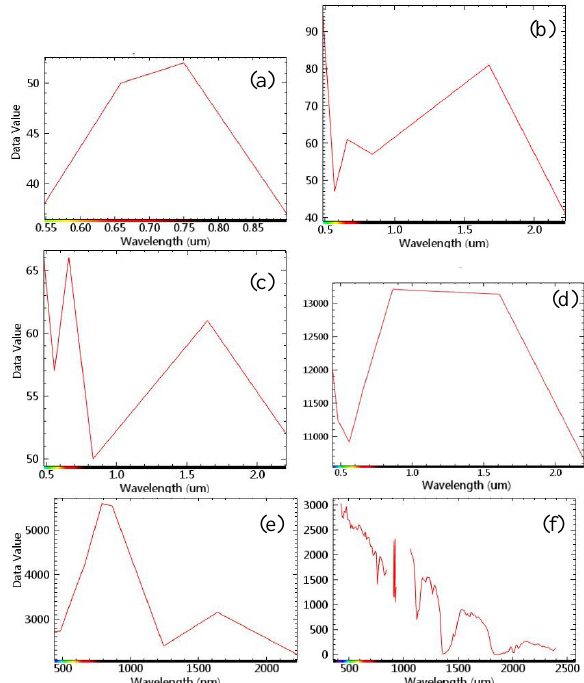
Figure 2 Spectral curves of different sensor images along the beach, where the satellite, sensor type, and acquisition time are